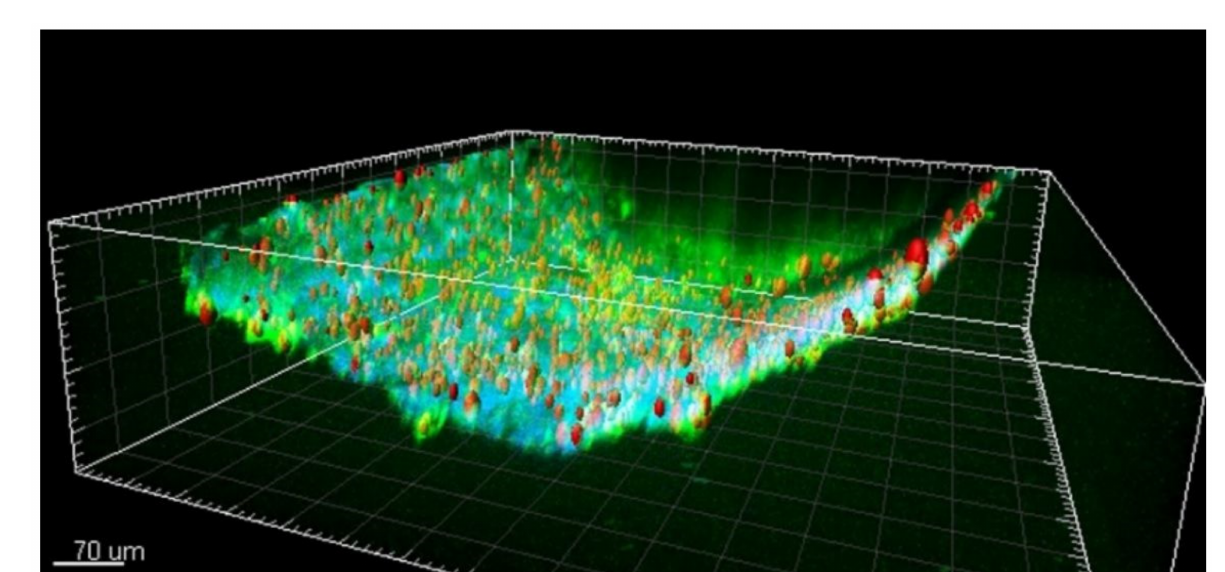
Figure 5. A representative two-photon 3D reconstruction image of lipofuscin autofluorescent particles. Scalebar: 70 µ m. Adapted from “Shedding light on human cerebral lipofuscin: An explorative study on identification and quantification” (Hakvoort et al., Journal of Comparative Neurology , 2020 [21]). A license to reuse this figure from its original source was acquired through RightsLink. (Reprinted with permission from ref. [21]. Copyright 2020